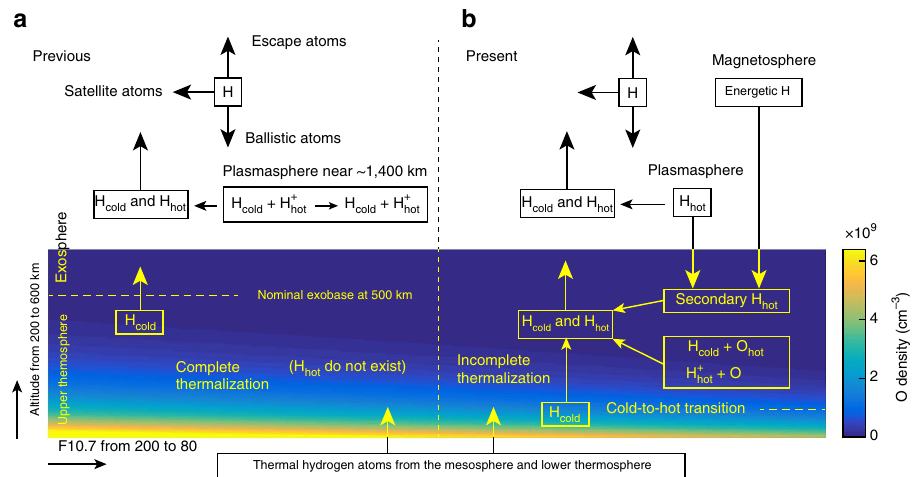
Figure 3 | The previous geocorona theory and the new physics implied in this study. ( a ) Only cold hydrogen atoms, with a Maxwellian kinetic distribution determined by the ambient oxygen temperature, are present in the upper thermosphere, since complete thermalization is assumed. ( b ) Incomplete thermalization, due to low oxygen density especially under solar minimum condition, allows the presence of hot hydrogen atoms in the upper thermosphere. Variation of the atomic oxygen density in the upper thermosphere with solar activity is calculated using the NRLMSISE-00 model 19 . We emphasize that in the present work the cold atoms refer to those atoms that diffuse upward from the lower thermosphere (that is, the thermal atoms), and the hot atoms are the ones that are kinetically energized through processes such as charge exchange and momentum